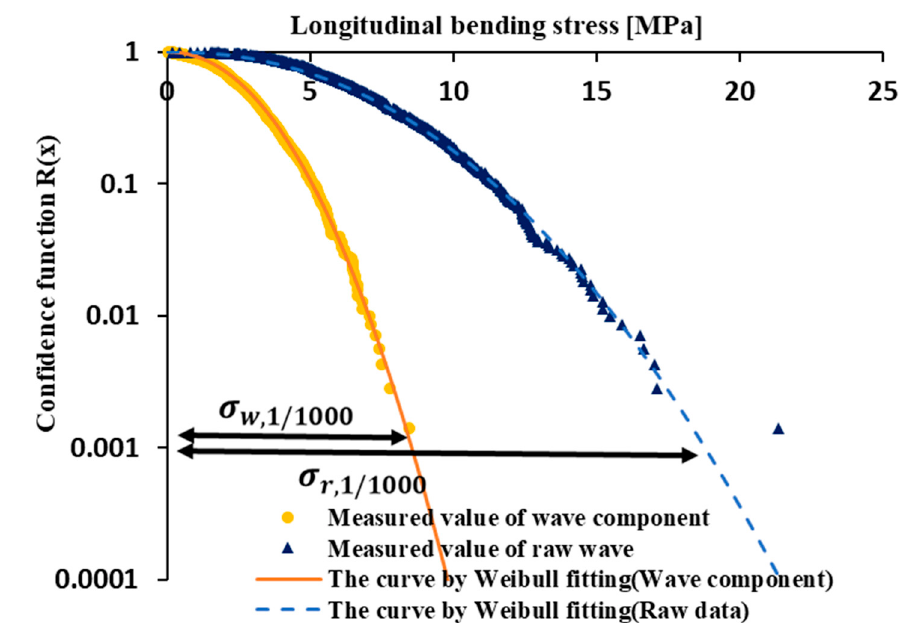
Figure 5. Weibull approximation and 1/1000 maximum expected value.